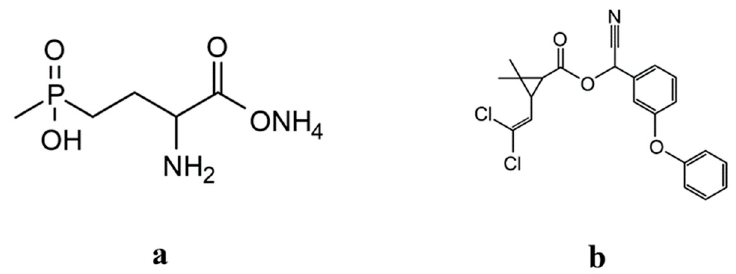
Figure 1. The active ingredients in ( a ) glufosinate ammonium (Gla) and ( b ) beta-cypermethrin ( β -CY), representing the two pesticides used in this